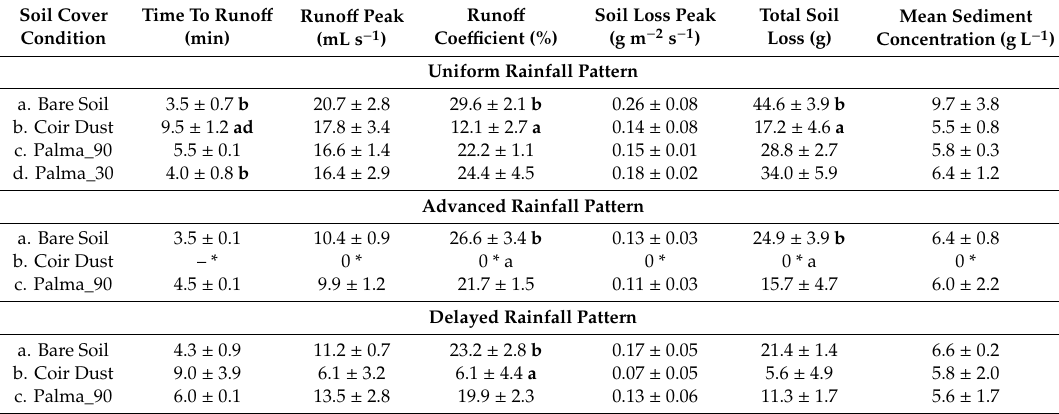
Table 1. Mean ± standard deviation (of three repetitions) of parameters related to runo ff and soil loss observed for all soil cover conditions and rainfall patterns simulated in the experiments. Within the same rainfall pattern, values for a soil cover condition followed by letters in bold ( p < 0.05) are statistically significantly di ff erent from the soil cover condition corresponding to that letter. For the coir dust and advanced rainfall pattern (*), no runo ff and soil loss were observed at the downstream end of the flume and time to runo ff was not